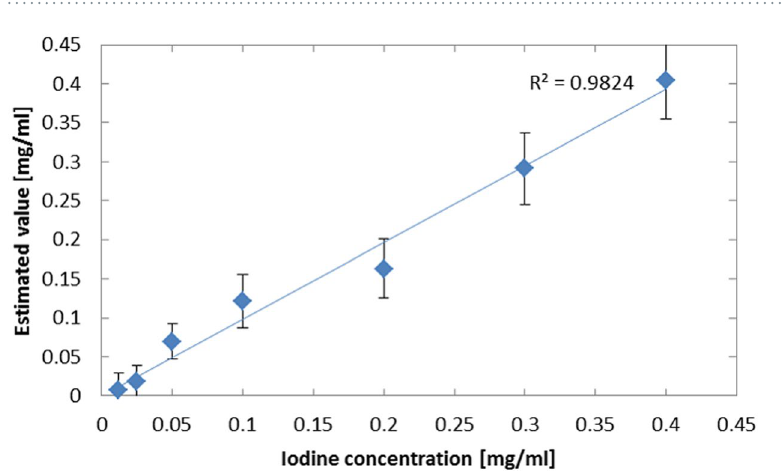
Figure 13. Voxel values along the yellow line in Fig. 12.